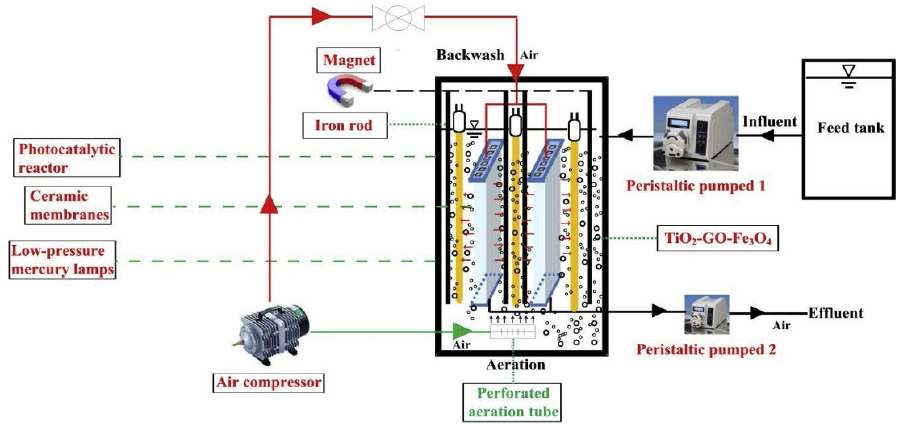
Figure 3. Schematic diagram of SMSMPR